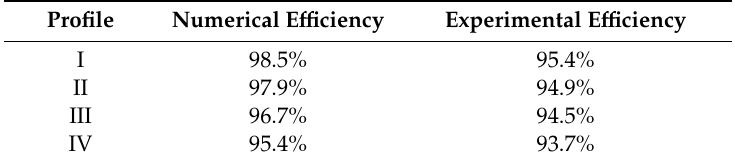
Table 4. Comparisonbetweennumericalandexperimentalelectrochemicalefficiencyofthecentroidprofiles.